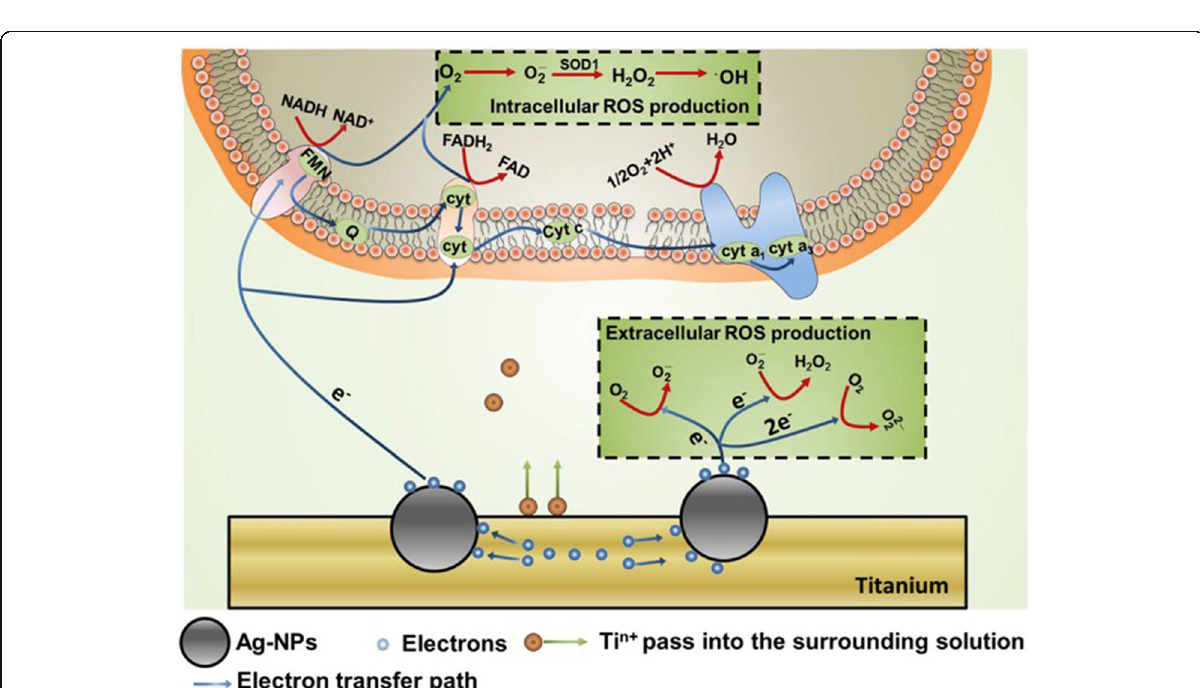
Fig. 1 The production of ROS induced by NPs in surrounding solution and cells [32]. The electrons generated from NPs could enter into cells and disturb the functions of respiratory chain, then enhance the intracellular ROS production. Electrons also could react with O 2 directly and increased the generation of extracellular